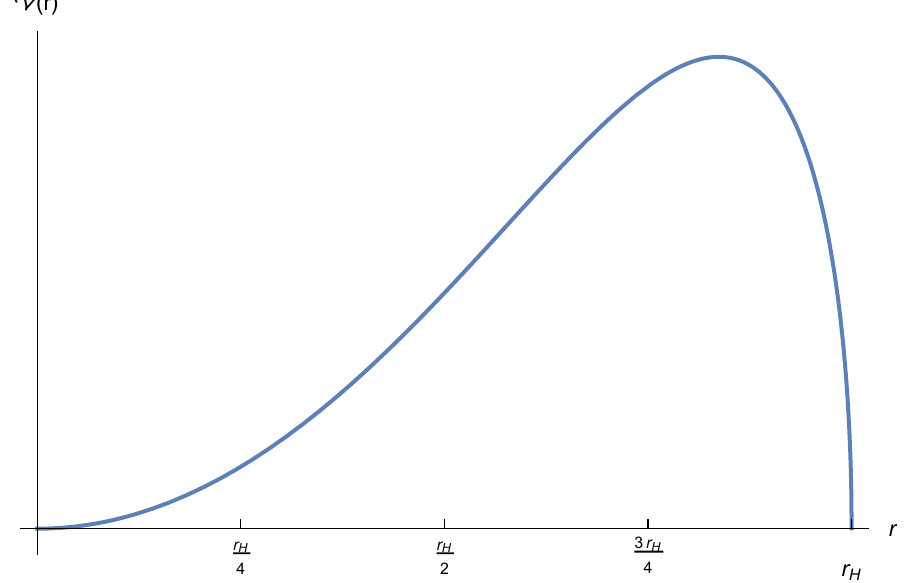
Figure 17. The \volume functional" V ( r ) for the AdS-Schwarzschild metric in eq.